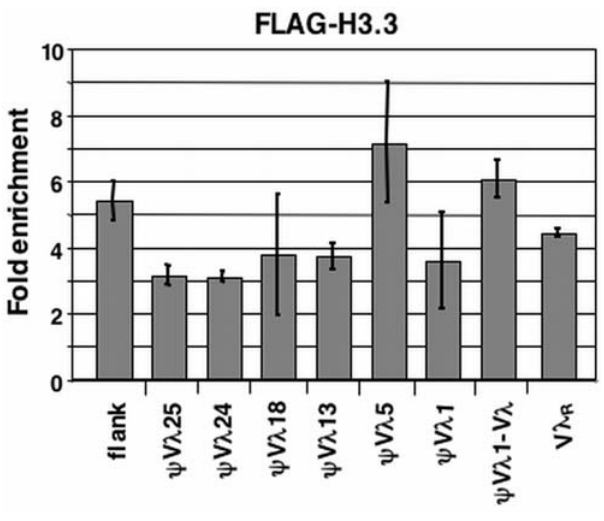
Figure 3. The H3.3 Histone Variant is Enriched at the DT40 Ig l Locus. Summary of a representative chromatin immunoprecipitation experiment, assaying enrichment of the H3.3 histone variant. Sites interrogated were: a region approximately 1 kb upstream of the y V l array (flank); the region between y V l 1 and V l ; y V l 1; y V l 5; y V l 13; y V l 18; y V l 24; y V l 25; and the rearranged V l R allele. Bars indicate standard deviation of at least three separate amplifications.